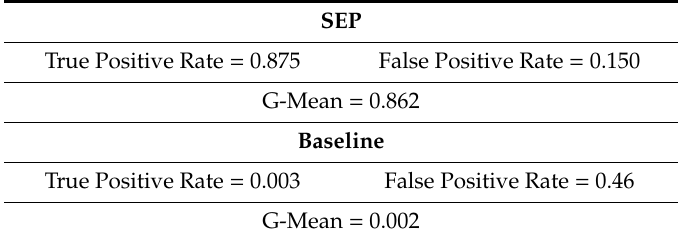
Table 4. SEP performance on smartwatch data collected for 66